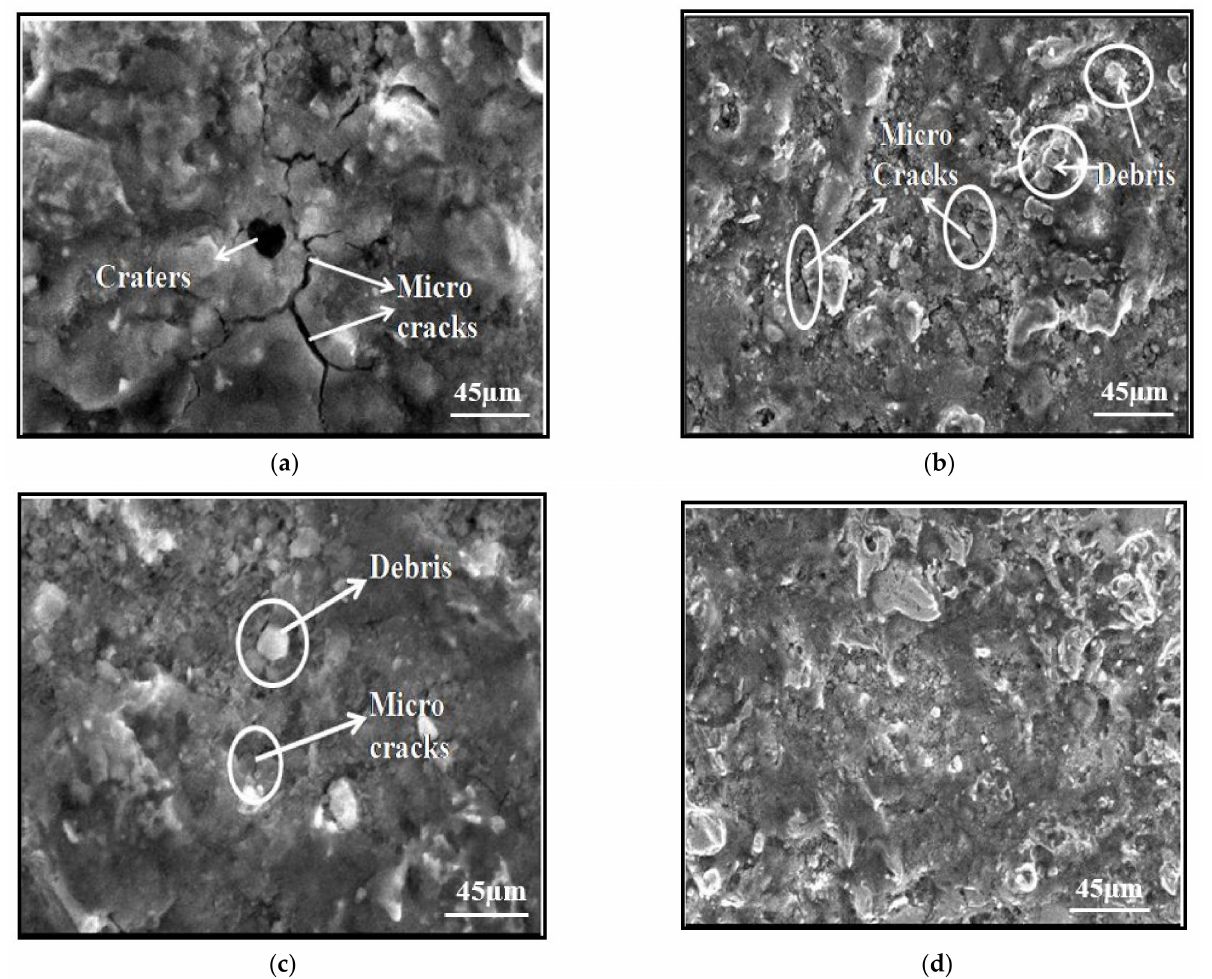
Figure 8. SEM micrographs of the ( a ) pure titanium alloy at 3000 × , ( b ) annealed titanium alloy at 1000 × , ( c ) oil-quenched titanium alloy at 3000 × , and ( d ) hardened titanium alloy at 1000 ×